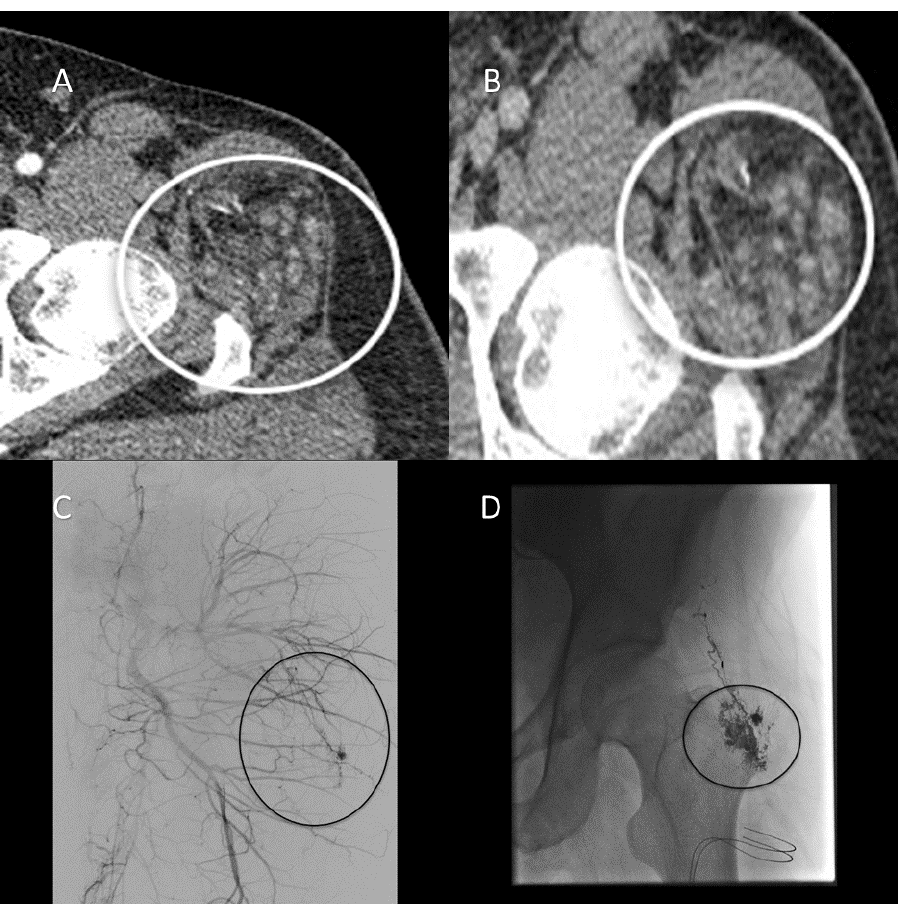
Figure 4. A 37-year-old man with Cowden syndrome and follicular thyroid cancer with a history of left hip pain and palpable abnormality. ( A ) Arterial-phase computed tomographic (CT) angiography of the lower extremities demonstrates an arterially enhancing lesion containing abnormal vasculature involving the left inferior gluteus medius muscle adjacent to the left hip supplied by branches of the lateral circumflex femoral artery (circle). ( B ) Venous-phase CT angiography demonstrates persistent enhancement consistent with an arteriovenous malformation (AVM). ( C ) Pre-embolization digital subtraction angiogram demonstrates an AVM supplied by branches of the left superior gluteal and lateral circumflex femoral arteries (circle). ( D ) Postglue embolization angiogram demonstrates stasis within AVM